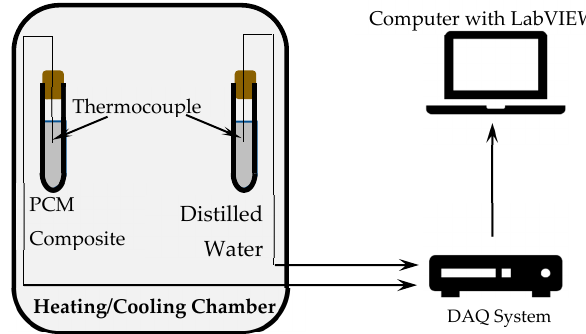
Figure 2. Schematic diagram of the experimental set-up used for the temperature history